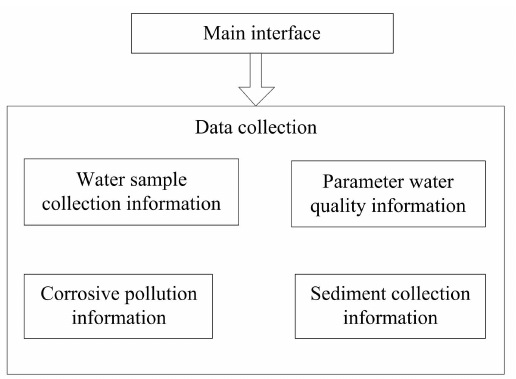
Figure 2. Functional module diagram of the marine environment corrosive pollution monitoring